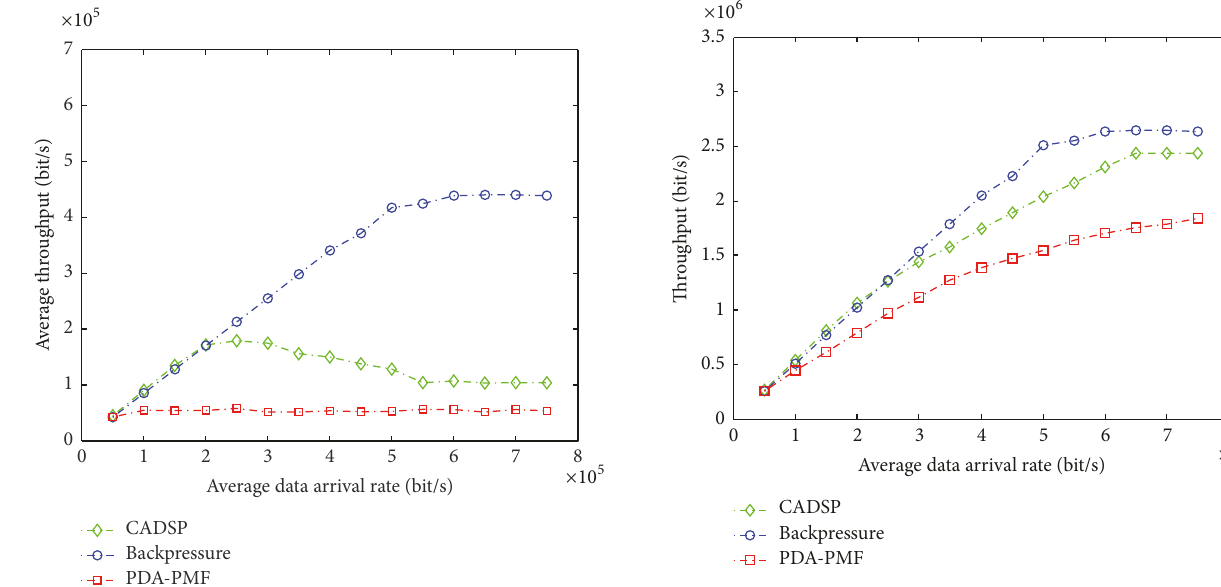
Figure 8: Comparison of throughput in multihop